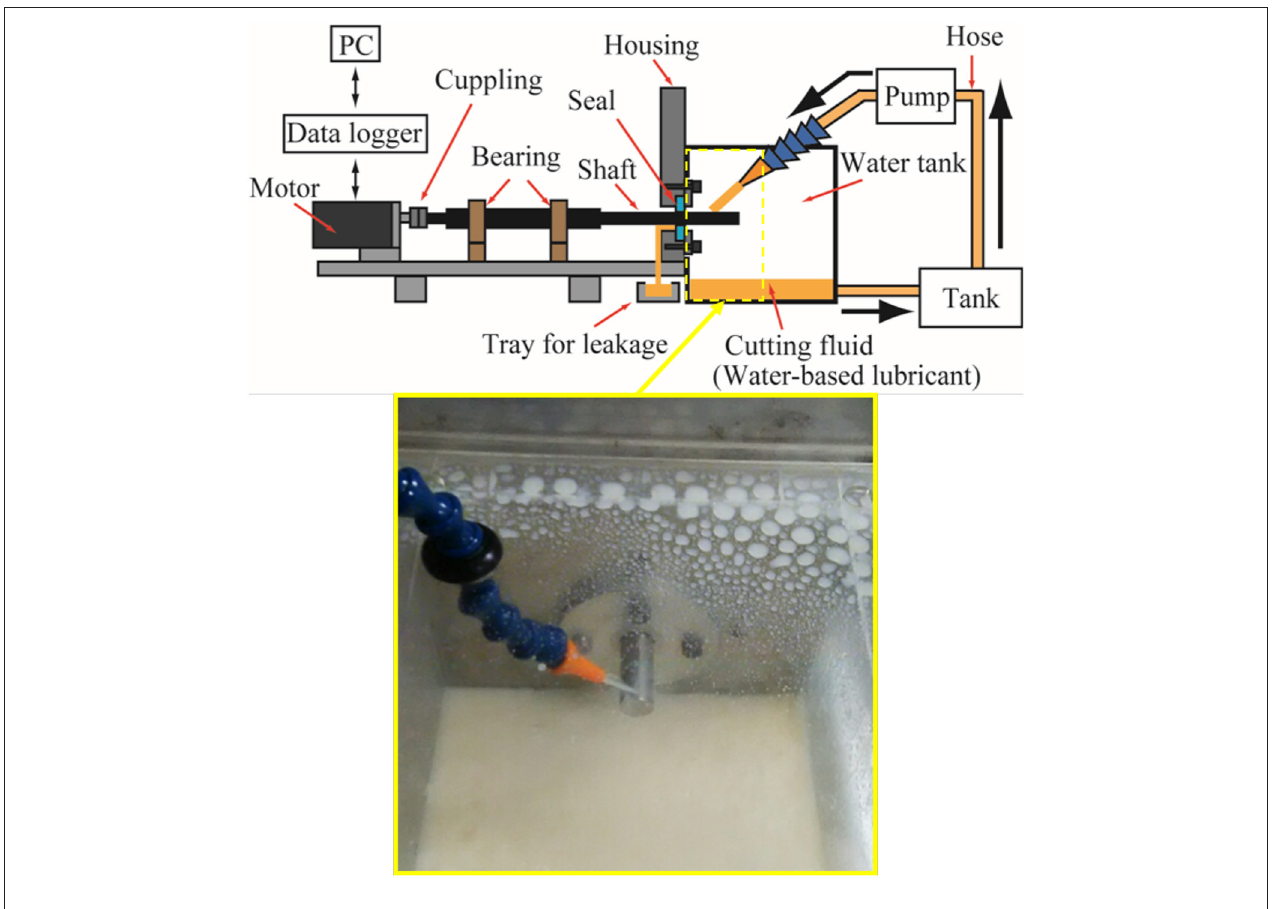
FIGURE 5 | Schematic and photograph of the testing device.